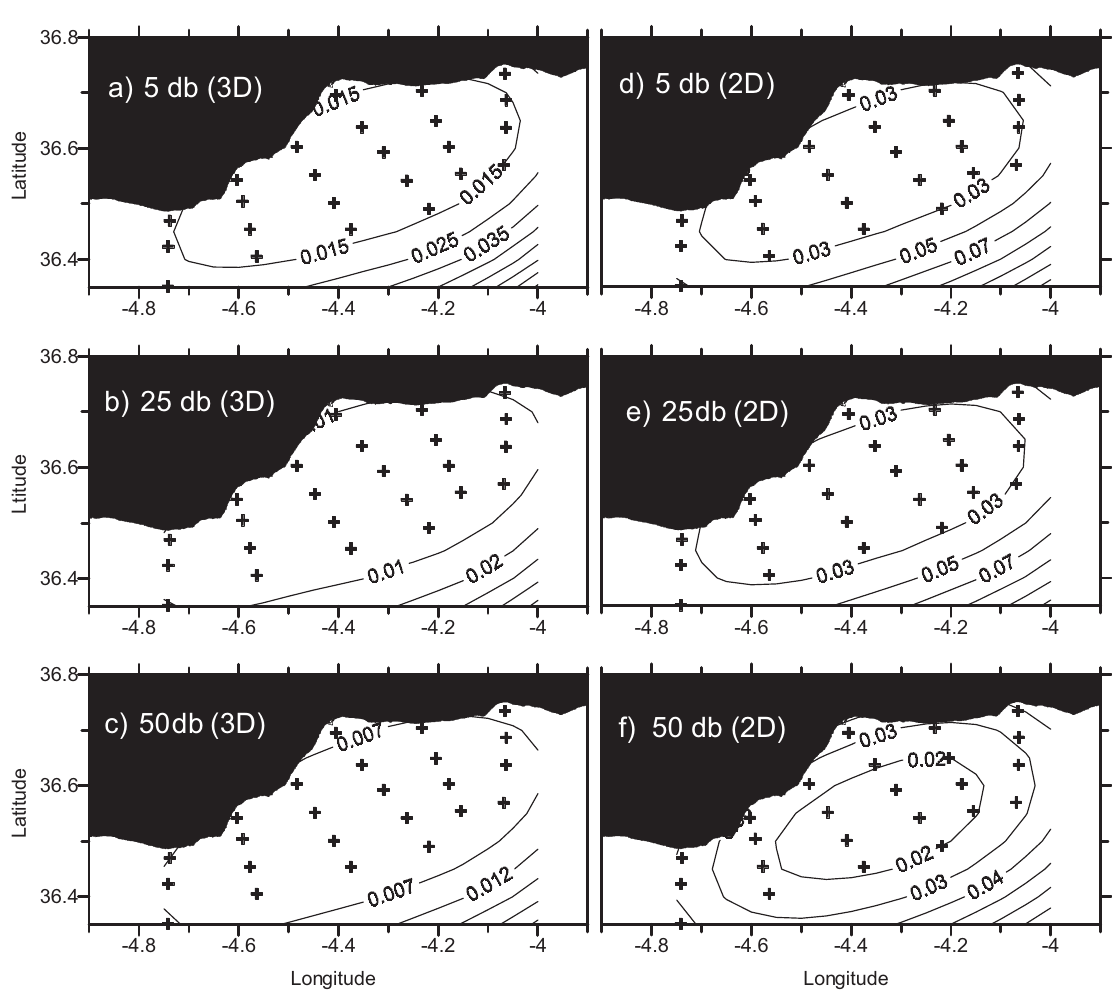
F IG . 9. – Error variance for the interpolated fields in Figure